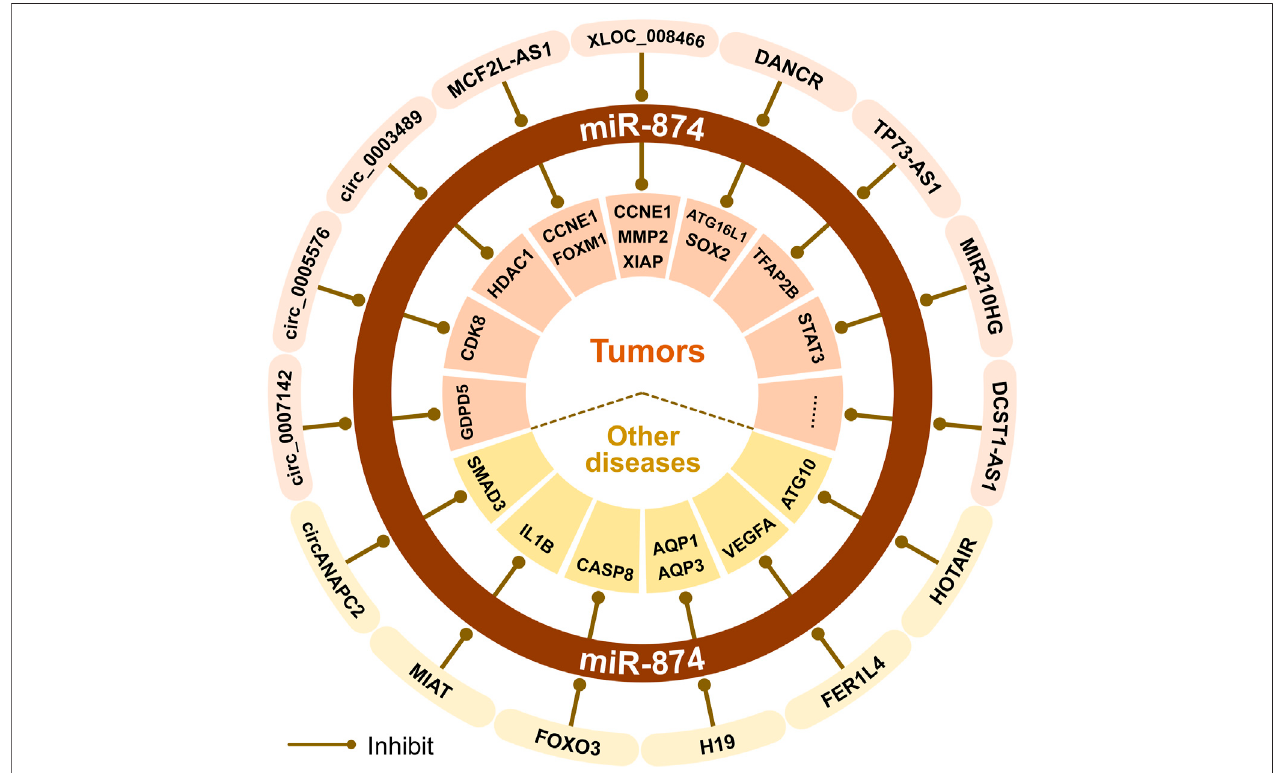
FIGURE 2 | The ceRNA mechanisms of miR-874 in cancer and other non-cancer diseases.